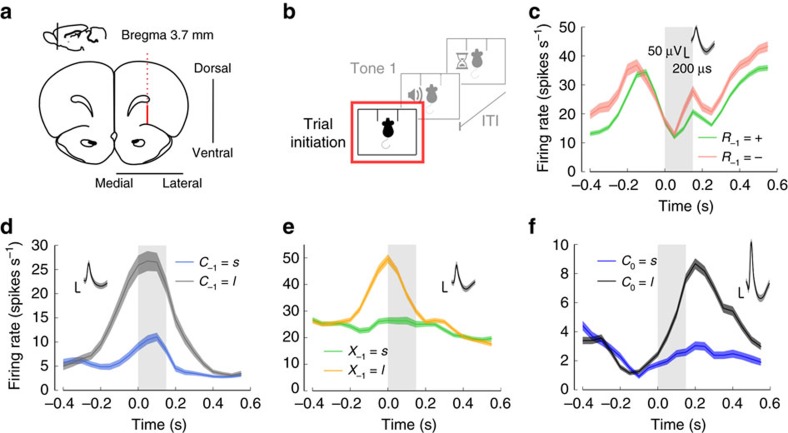
OFC neurons encode relevant past information and anticipate upcoming choices even before stimulus onset.(a) Electrode's path (dashed red line) and recording sites (solid red line) in rat lOFC depicted in a coronal section representation at 3.7 mm AP, 2.5 mm ML and 1.6 mm DV from Bregma. (b) Neuronal responses were aligned to trial initiation, defined as the time at which the rat starts the trial by poking the central socket. (c) Example neuron encoding reward in the previous trial R−1 (either + or −). This particular neuron fires more strongly for non-rewarded previous trials. (d) Example neuron representing choice in the previous trial C−1 (either s or l). (e) Example neuron tracking second-order prior X−1=C−1 × R−1 (either s or l). (f) Example neuron encoding upcoming choice C0 as a function of time. This neuron conveys information about rat's upcoming choice before stimulus onset (stimulus onset always happens to the right of the shaded area). (c–f): Time zero corresponds to trial initiation. The period of time between trial initiation and the shorter stimulus onset (150 ms) is indicated with shaded areas. Curves correspond to trial-averaged firing rates smoothed with a causal sliding rectangular window (size of 100 ms and step of 50 ms), and shaded areas around them correspond to s.e.m. Insets represent spike waveform for each neuron (black line, mean; shaded area, s.d.).